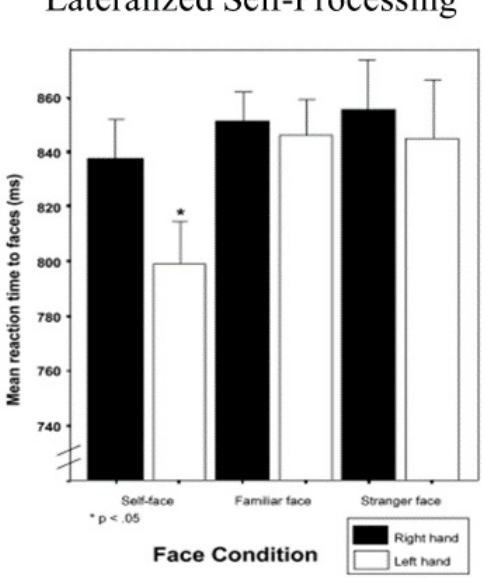
Figure 1. Left-hand advantage in reaction times to self-face recognition.